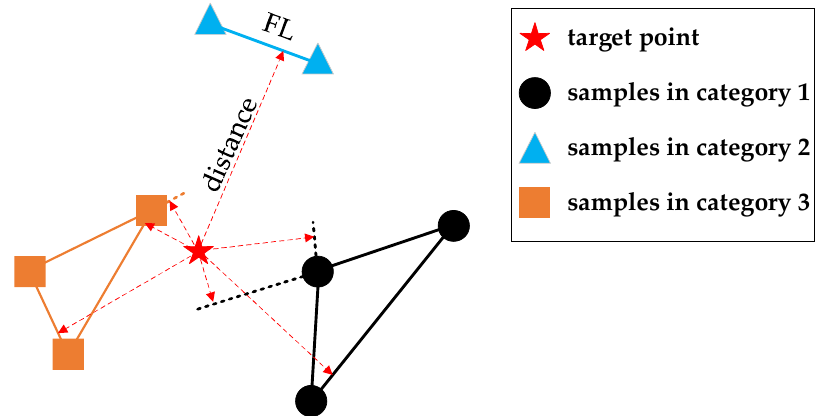
Figure 11. Nearest feature line classification presented in 2-dimensional form.